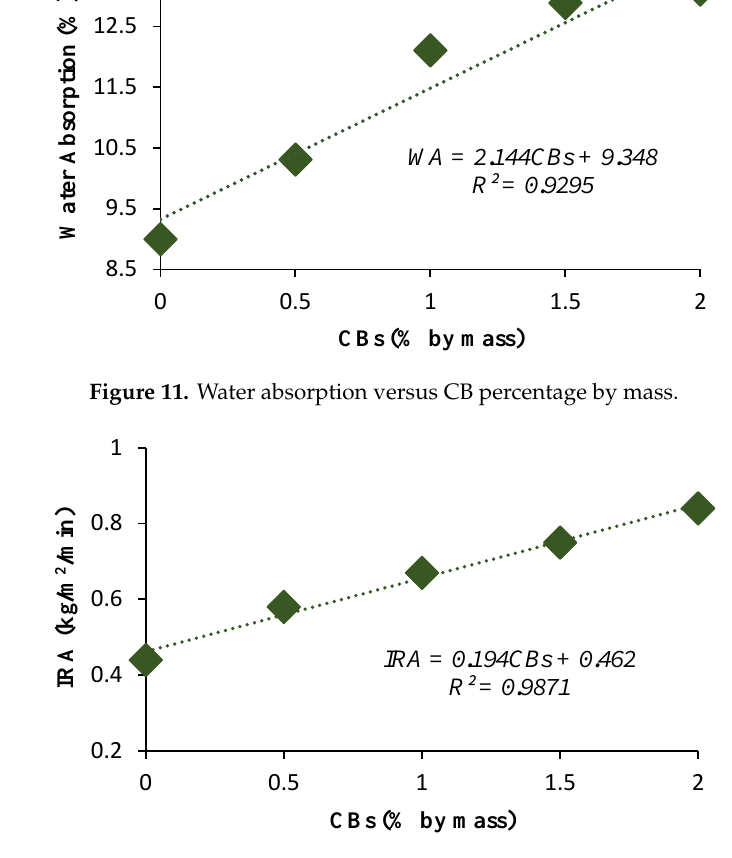
Figure 12. IRA versus CB percentage by mass.